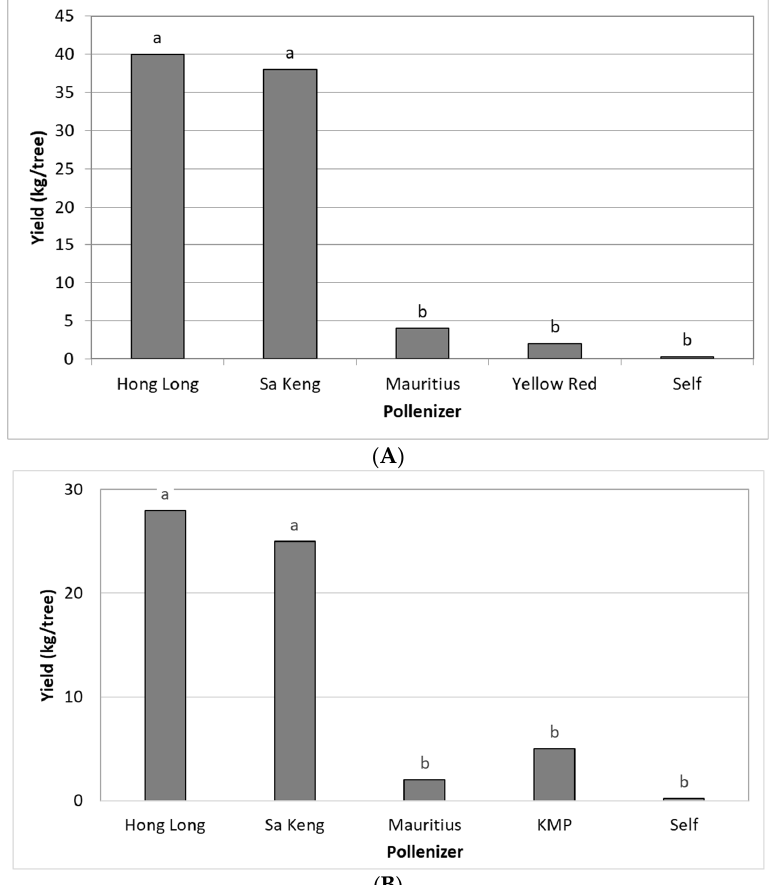
Figure 3. The effect of different pollinizers under nets on the yield of the adjacent FZX trees at Moran orchard in 2020 ( A ) and 2021 ( B ). Mean values of each column (pollinizer) followed by different letters differ significantly per Duncan’s new multiple range test, p < 0.05. Data on yield are the mean of 4 FZX trees (4 replicates).